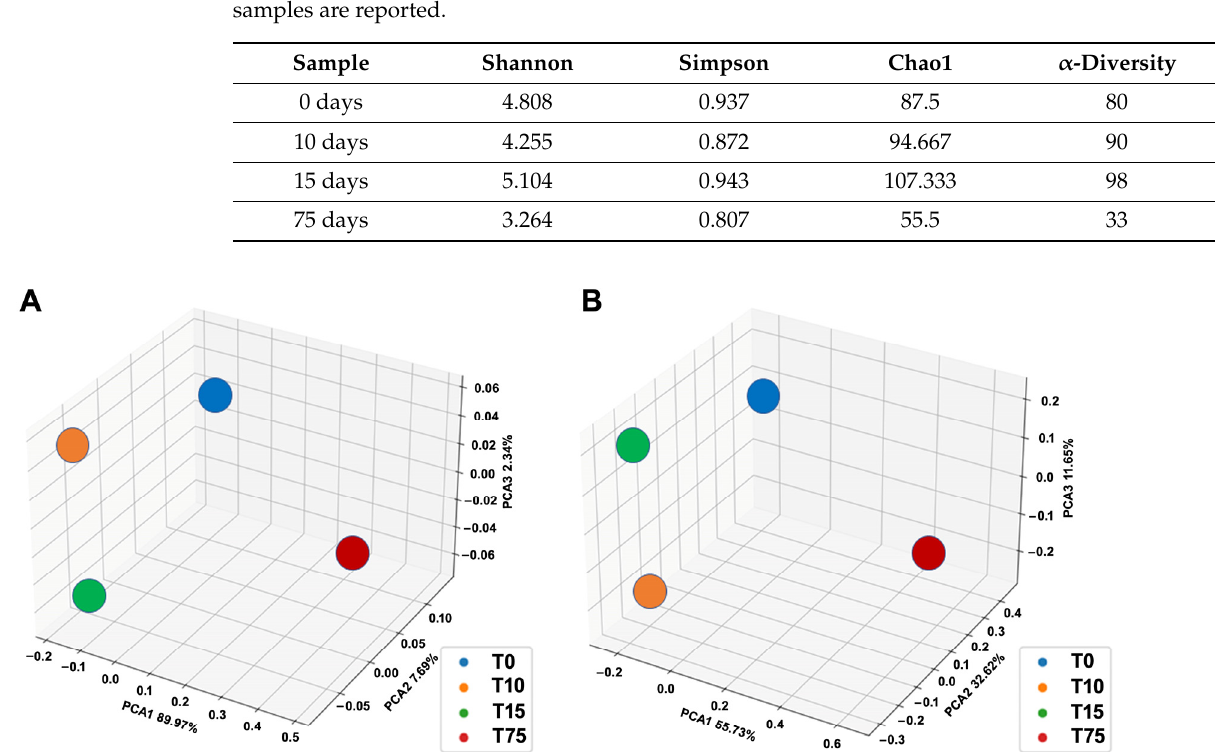
Figure 5. Principal coordinate analysis (PCA) of beta-diversity metrics for the RRIA samples se- quenced by 16S rRNA amplicon NGS. ( A ) Unweighted Unifrac distance; ( B ) Bray–Curtis dissimi- larity.